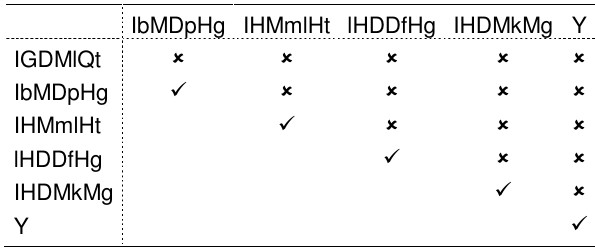
Matrix of Overall Correlation and